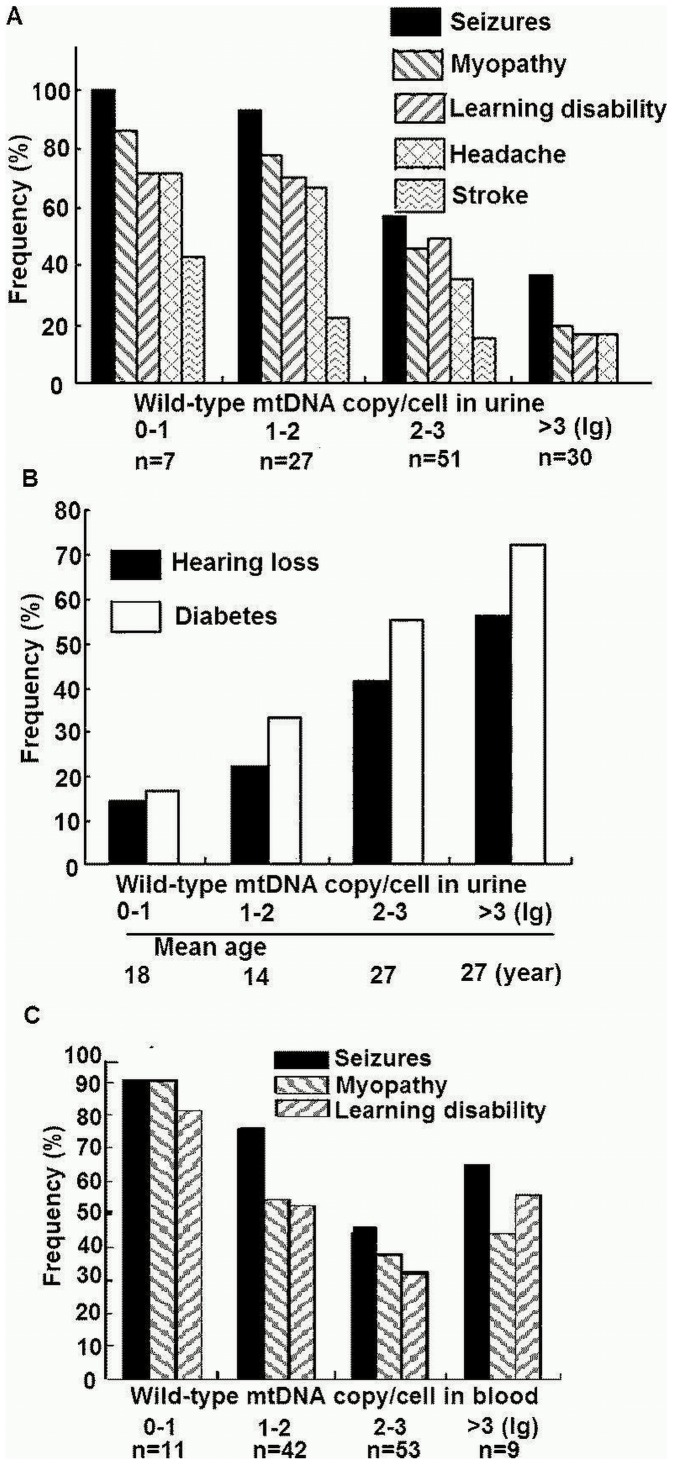
Relationship between the frequencies of major symptoms and the wild-type mtDNA copy number per cell in urine and blood.The 115 patients were divided into 4 subgroups based on the lg value of wild-type mtDNA copy number per cell in urine and in blood. Frequency of the major symptoms are shown in relation to the wild-type mtDNA copy number per cell in urine (panels A and B) and in blood (panel C).